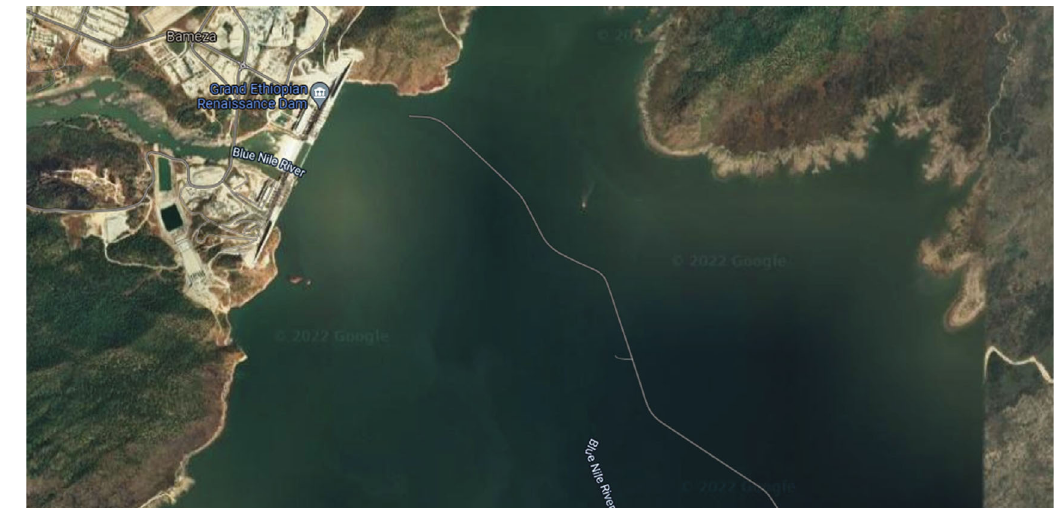
Figure 2: Geographical map location of GERD from satellite